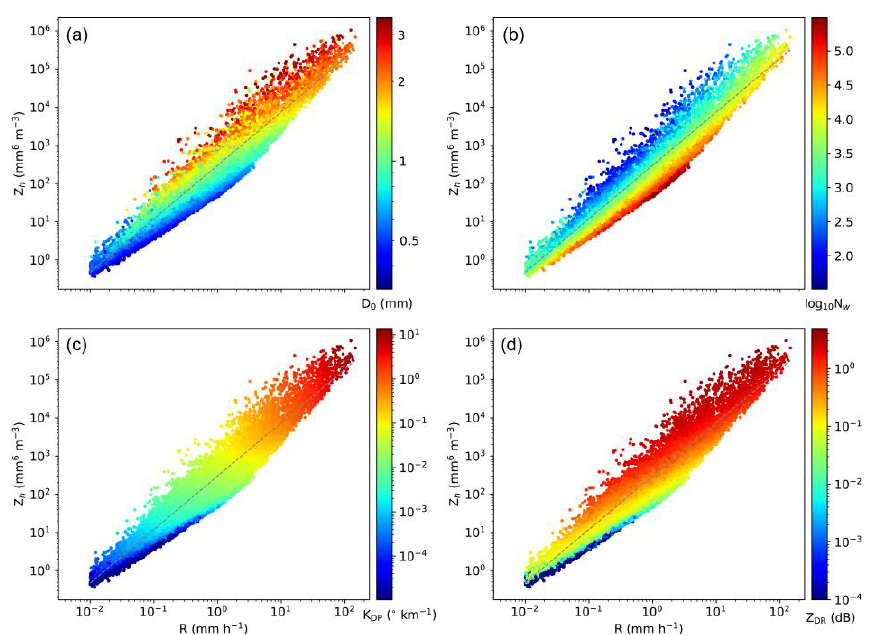
𝑁 𝑤 , ( c ) 𝐾 DP , N w , ( c ) K DP , 10 10